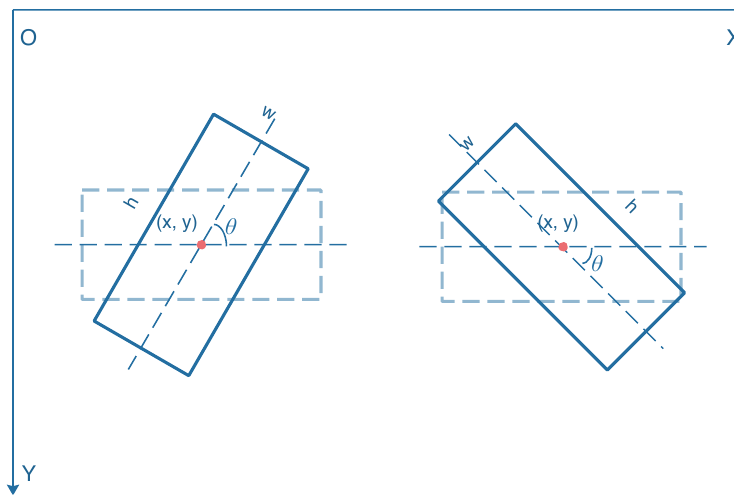
Figure 5. Geometric representation of two rotated bounding boxes. The rotation angle θ of the bounding box on the left is 60 ◦ , and the rotation angle θ of the bounding box on the right is − 45 ◦